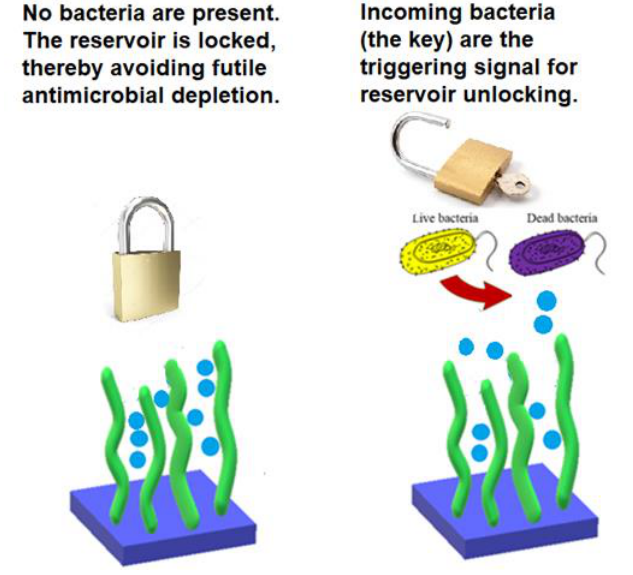
Figure 9. The concept of smart bacteria-activated polymer brush nanocoatings.